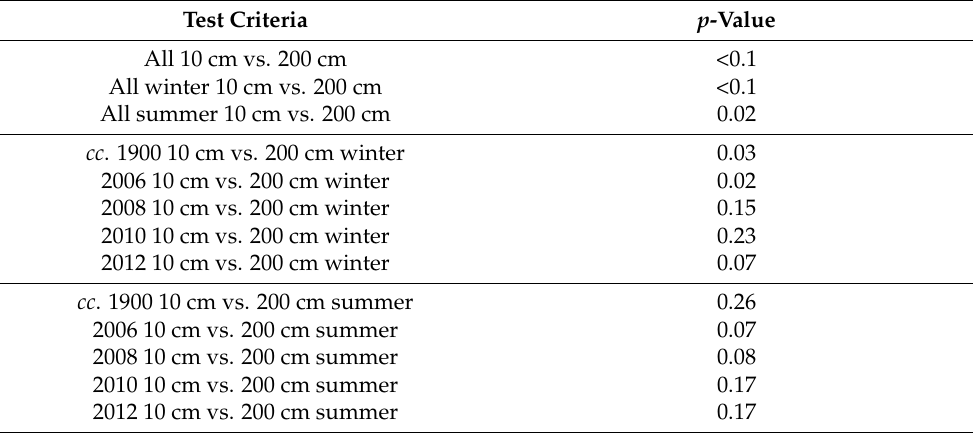
Table 4. Test criteria, p values and significance levels of Mann–Whitney testing. Test Criteria p -Value